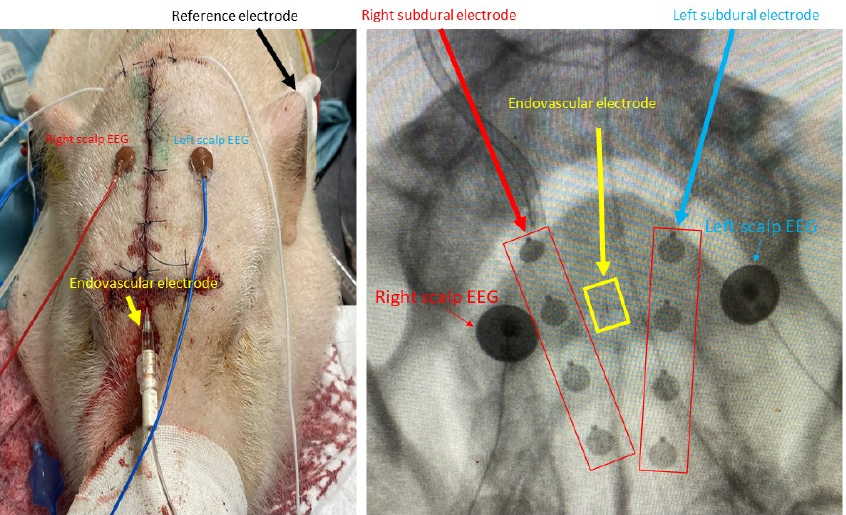
Figure 2. Placement of scalp, subdural, and endovascular electrodes. Each electrode was placed within a close distance using X-ray guidance.